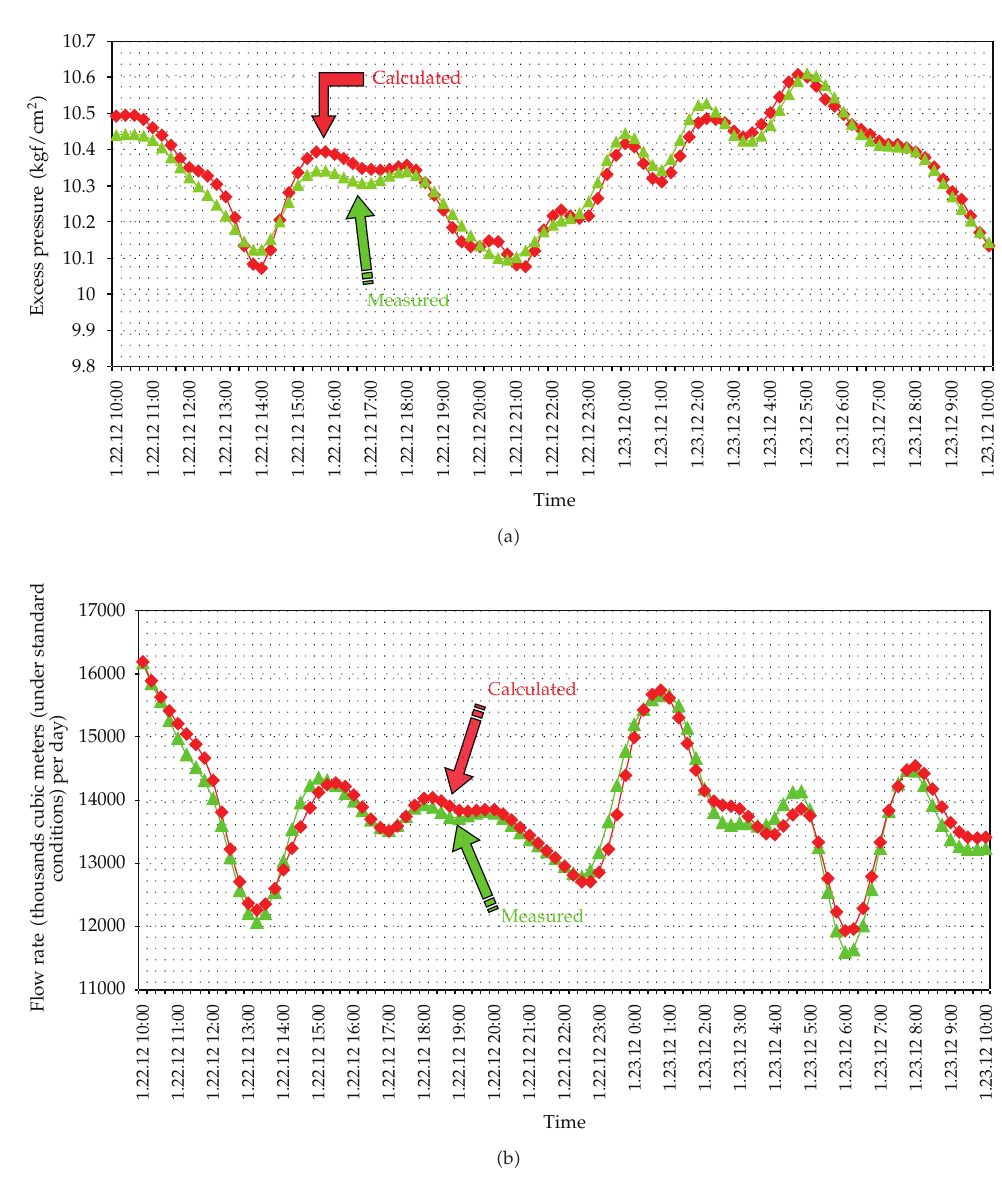
Figure 6: Example of curve correlation of calculated and measured pressure history (cid:6) a (cid:7) and mass flow rate (cid:6) b (cid:7) for one from the IPs used in